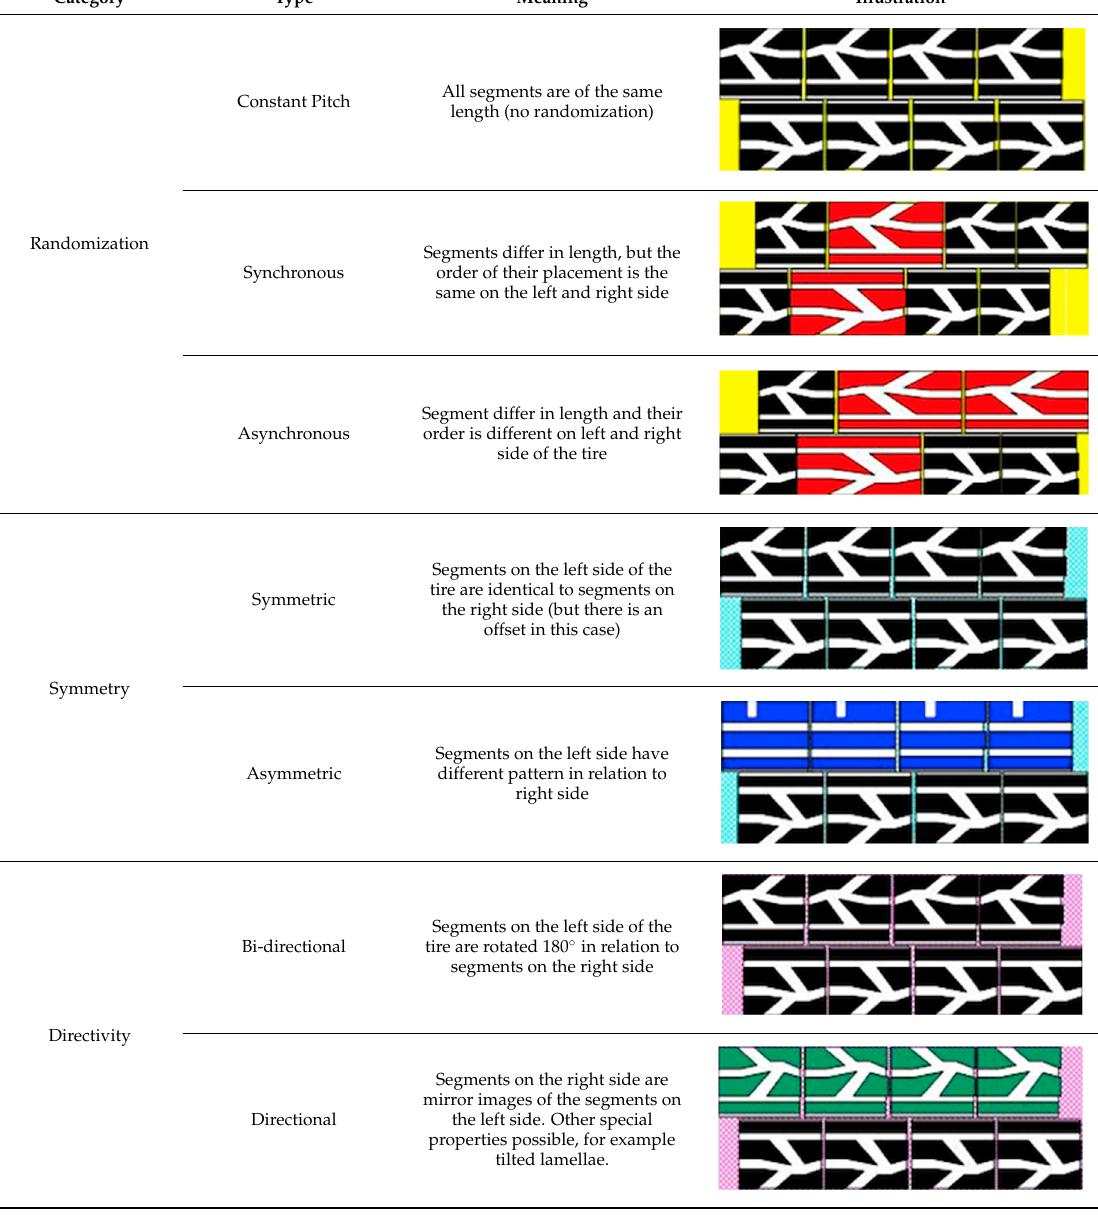
Segment differ in length and their order is different on left and right